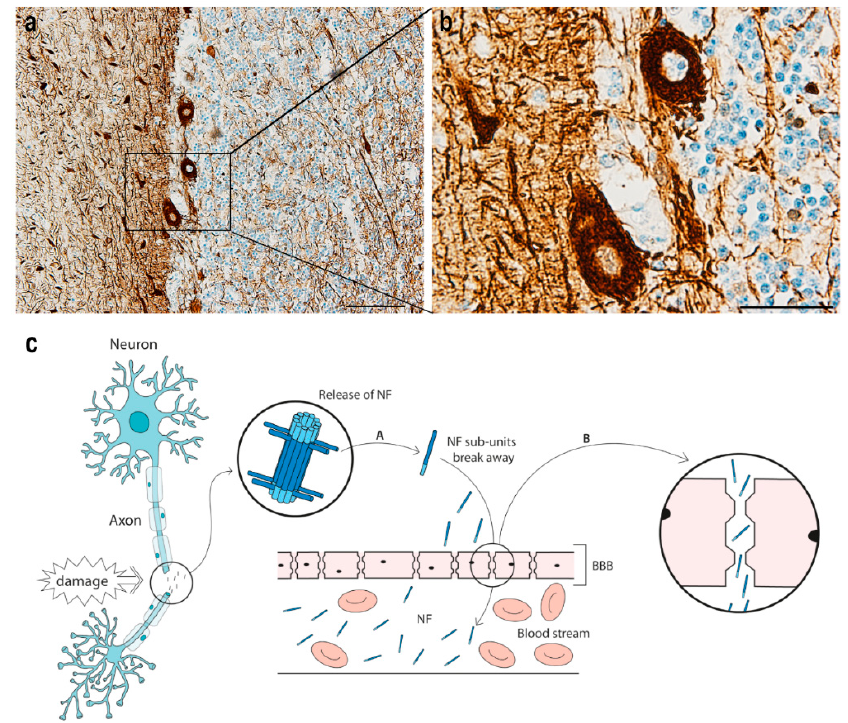
Figure 1. Neurofilament after neuroaxonal damage. ( a ) Immunohistochemical staining of neurofilament-positive neurons in post-mortem human ischemic cerebellum tissue. Scale bar: 100 μ m. ( b ) High magnification of squared area in ( a ) showing neurofilament-positive neurons. Scale bar: 40 μ m. Neurofilament immunohistochemical staining was performed on parallel tissue sections